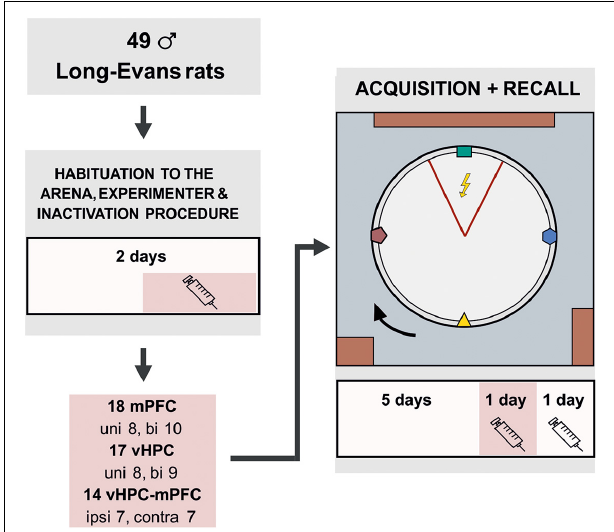
FIGURE 1 | Experimental design for the active place avoidance learning and retrieval. The rats were habituated on the arena for 2 days prior to the training. The experimental task consisted of 5 days of 20 min learning sessions, in which the rats learned to avoid a static sector on the rotating arena based on room-bound cues. The colored cues, placed on the arena wall and rotating with the arena, were irrelevant for successful avoidance. On day 2 of habituation and on the day 6 (20 min prior to the training), the rats were given muscimol injections based on their experimental group. The session on day 7 was used as a control; saline injections were administered to the rats 20 min before the session, similarly as in the experimental groups. bi, bilateral; uni, unilateral; ipsi, ipsilateral; contra,